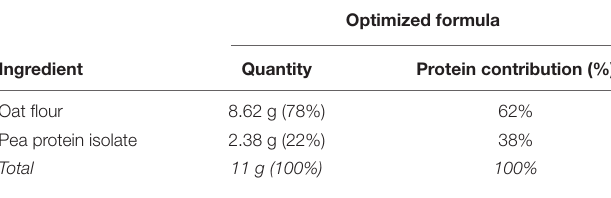
TABLE 6 | Optimized mixture for yogurt